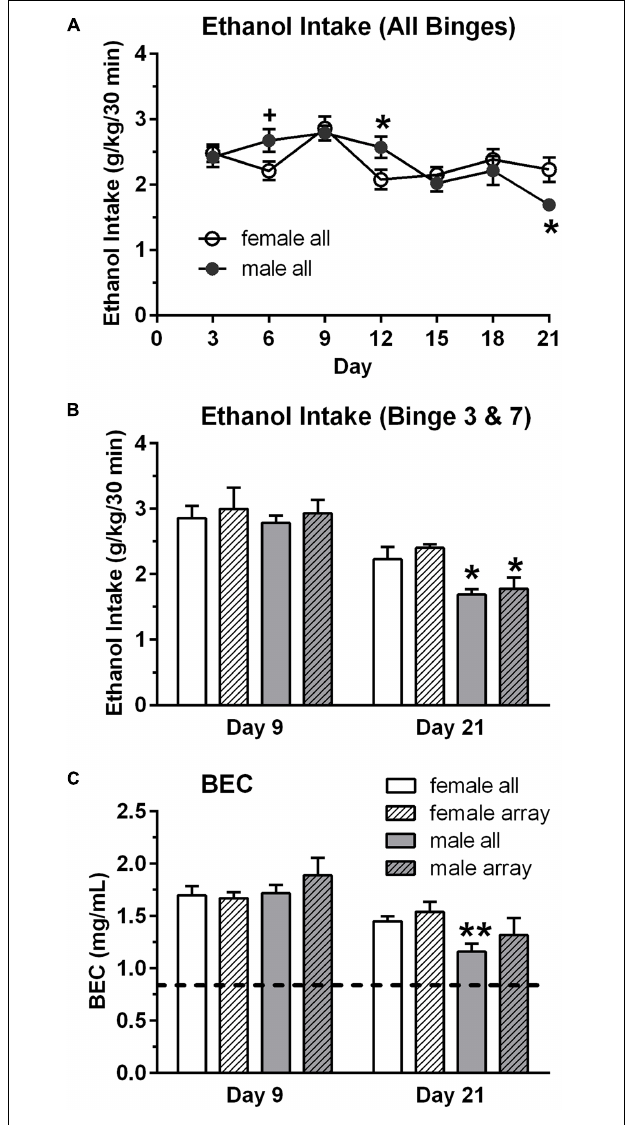
FIGURE 1 | Binge ethanol intake (A,B) and blood ethanol concentration (BEC, C ) in male and female mice. Mice in the binge groups had a total of seven binge drinking sessions, with a binge session every 3rd day (A) . BEC was measured at the end of the 3rd (day 9) and 7th (day 21) binge sessions. Although overall binge ethanol intake, averaged across the seven sessions, did not differ in the female (2.34 g/kg) and male (2.35 g/kg) mice, ethanol intake and corresponding BECs were lower in the male vs. female mice on the final binge session (day 21, B,C ). However, BECs greatly exceed the criteria for binge drinking on all days (0.80 mg/mL; depicted by dashed line in C ). Shown are mean ± SEM for all mice in the binge groups ( n = 9/sex), which included the mice in the subgroup that were used for the qRT-PCR analysis ( n = 4/sex), and for the mice in the subgroup that were used for the qPCR arrays ( n = 3/sex). + p = 0.06, ∗ p < 0.05, ∗∗ p < 0.01 vs. respective female all or female array